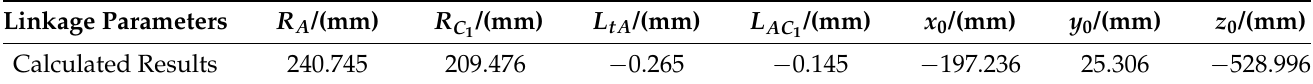
Figure 11. ( a – f ) Process of linkage parameters measurement of multi-axis LEMT. Table 2. Linkage parameters calculated